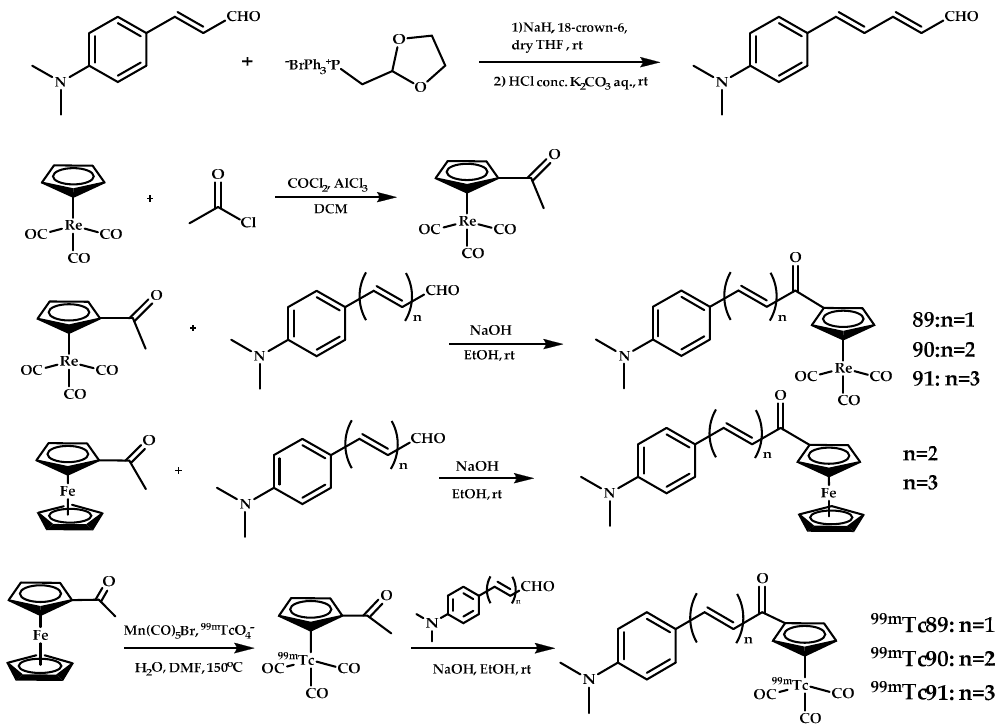
Figure 22. [ 99m Tc] coordination compounds [ 99m Tc]89–91 based on chalchone–mimic scaffolds and their Re analogues 89–91 .